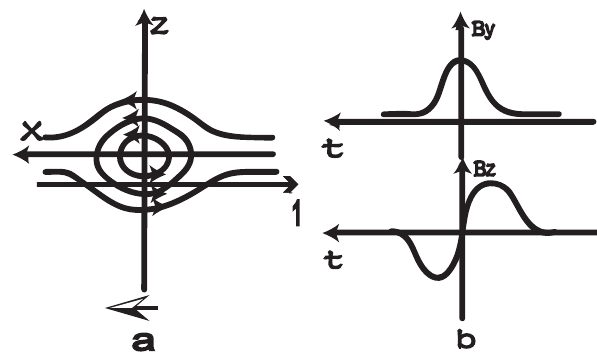
Fig. 1. Illustration of the magnetic signature in the magnetic flux rope. Panel (a) demonstrates the cross section of an earthward mov- ing magnetic flux rope. Panel (b) displays the magnetic field com- ponents observed by satellite along line